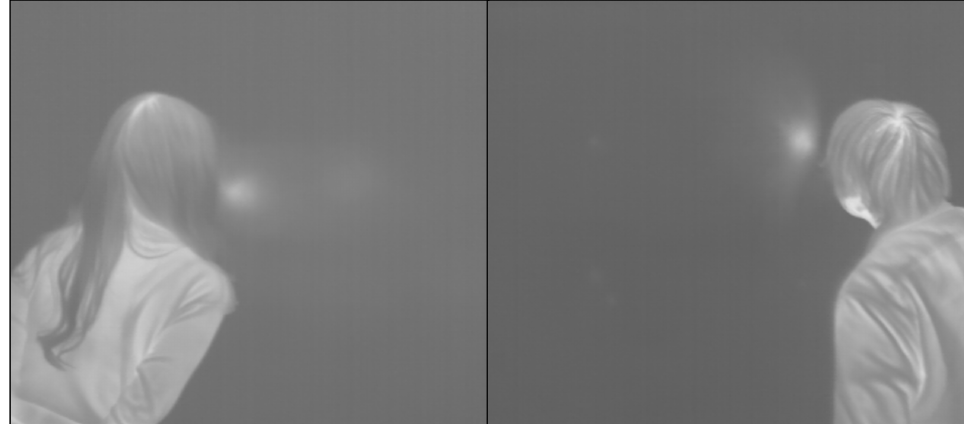
Figure 2. Form of conduction hot spot by exhalation